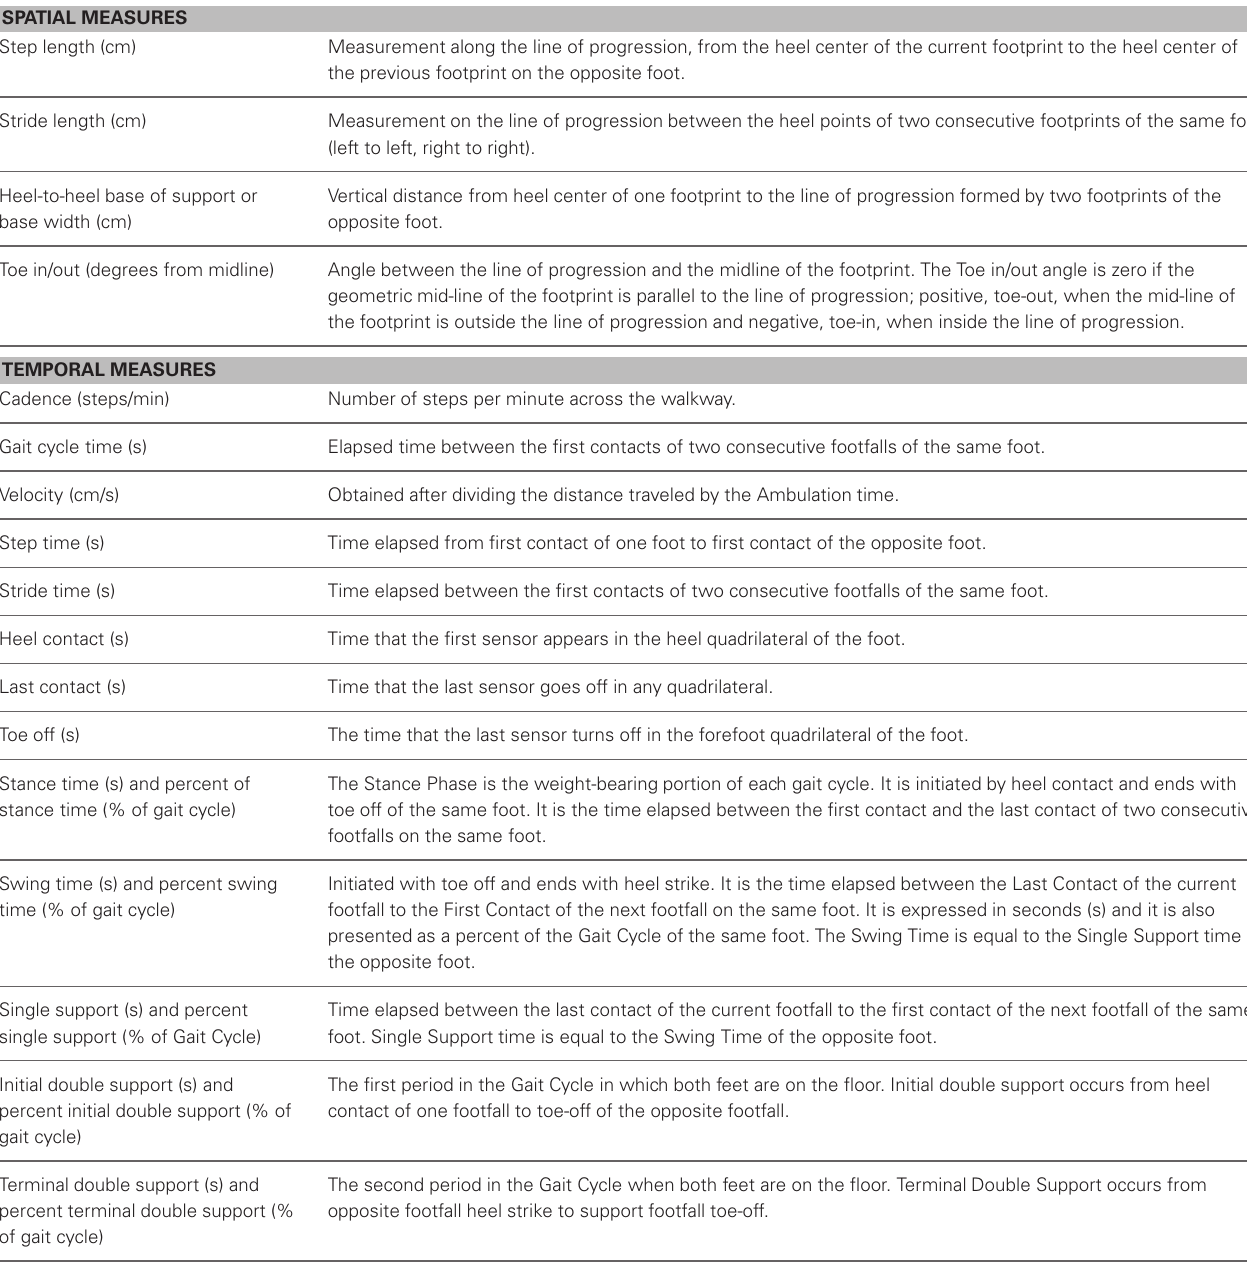
Table 2 | Temporal and spatial measures of gait recorded by the GAITRite walkway